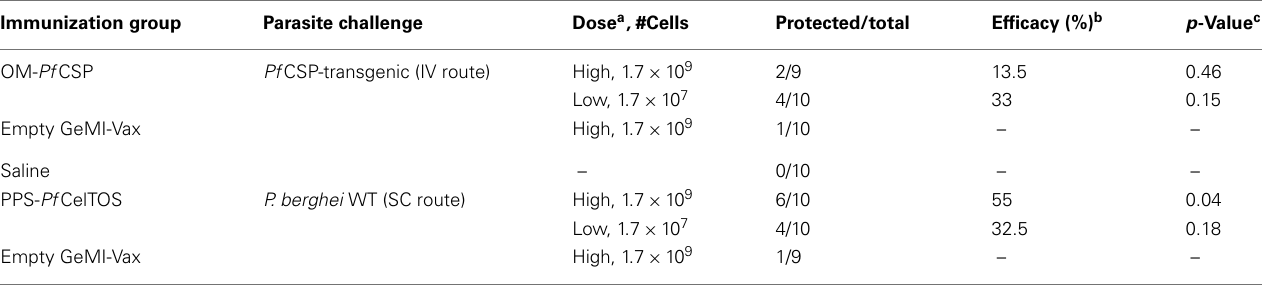
Table 3 | Immunization with high dose PPS-PfCelTOS protects mice against challenge with wild-type P. berghei sporozoites. Immunization